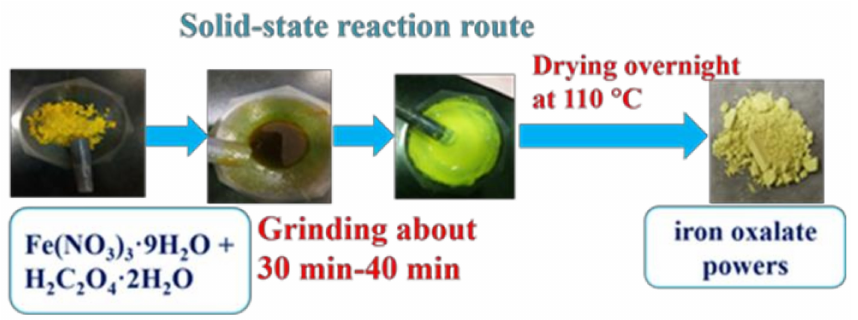
Figure 8. The flow-process diagram of preparation of iron oxalate powders